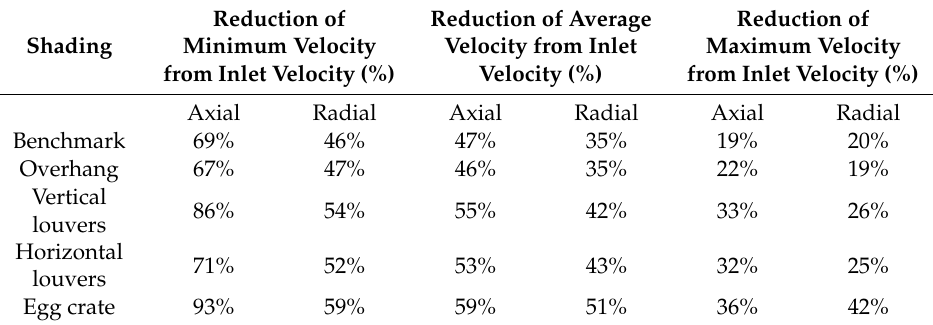
Table 15. Reduction from inlet velocity.